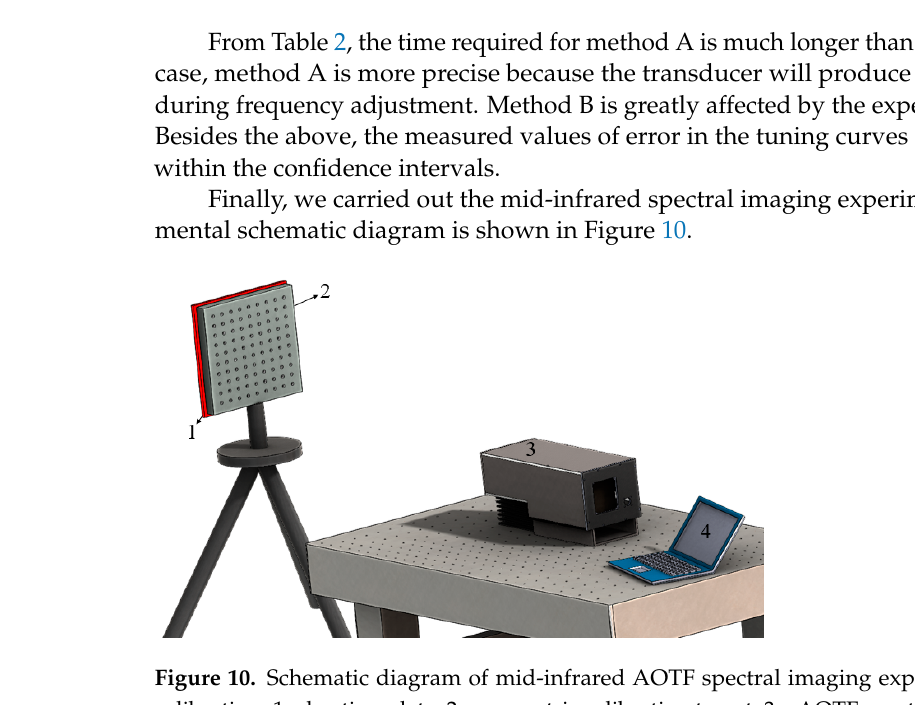
( b ) Figure 11. Spectral imaging experiment based on mid ‐ infrared AOTF. ( a ) Actual image of diffracted light; ( b ) the partially enlarged view of the target. In Figure 11, the circles represent the simulated imaging points, and the red asterisks represent the actual imaging points. If we remove the two calibration points within the red dotted box, we can find that the simulated imaging points are all located near the actual imaging areas. After the geometric calibration of the AOTF crystal, the ideal imag ‐ ing points are closer to the actual imaging points, but the effect is not obvious. The main reasons lie in the following aspects: (1) the aberration of mid ‐ infrared AOTF is much smaller than that of the visible band; (2) the geometric calibration result of AOTF crystal has little difference from the reference value; (3) limited by the angular aperture, the field